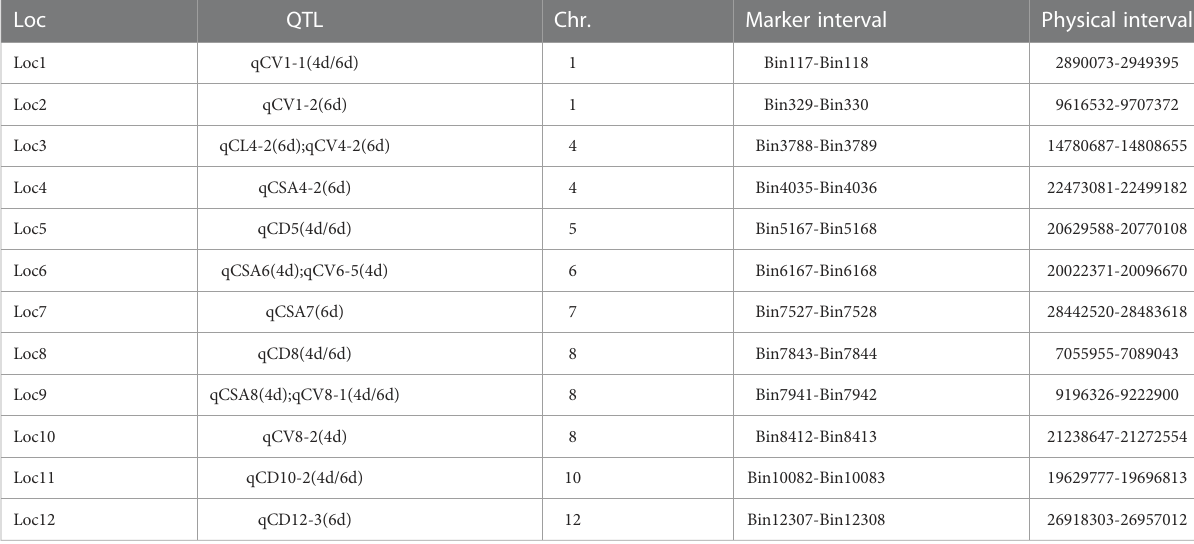
TABLE 3 Identi fi ed 12 stable QTL